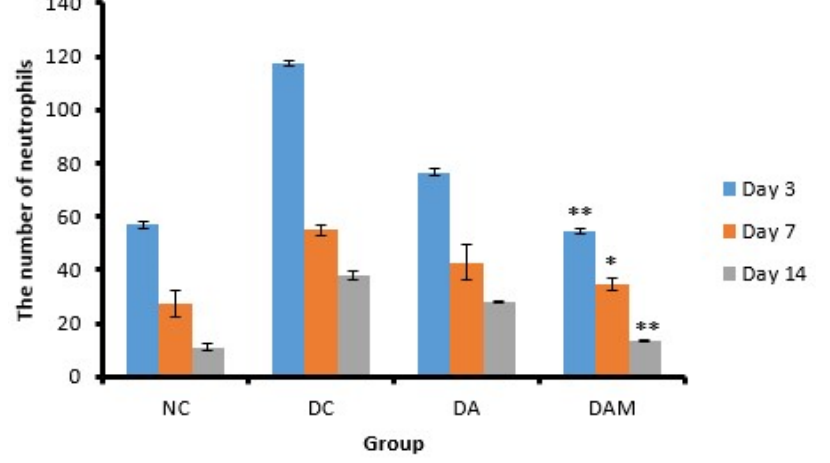
Figure 6. Number of neutrophils at the three variation times. Notation on the graph shows the result of the statistical test ( α < 0.05). * and ** notation shows insignificant differences with NC but significant differences with DC. * = 0.01 ≤ α < 0.05; ** = α ≤ 0.01. NC: normal group; DA: alginate treatment group; DAM: alginate–mangosteen rind extract treatment group; and DC: diabetic group.